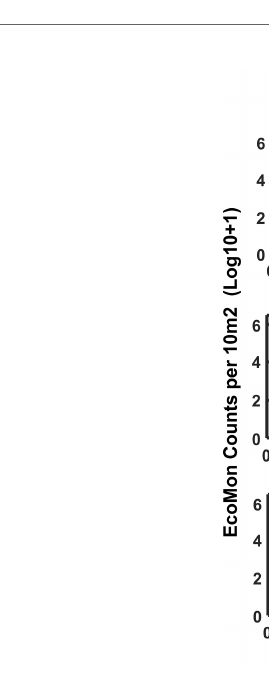
FIGURE 3 | Functional regression analysis of COI sequence numbers versus morphological microscopic counts per 10m 2 for selected taxonomic groups of zooplankton. Symbols indicate regions for sample collections: Mid-Atlantic Bight (MAB), Georges Bank (GB), Gulf of Maine (GoM). Numbers are Log10+1 conversions; regression equation coef fi cient (r) and statistical signi fi cance (p) are indicated for each